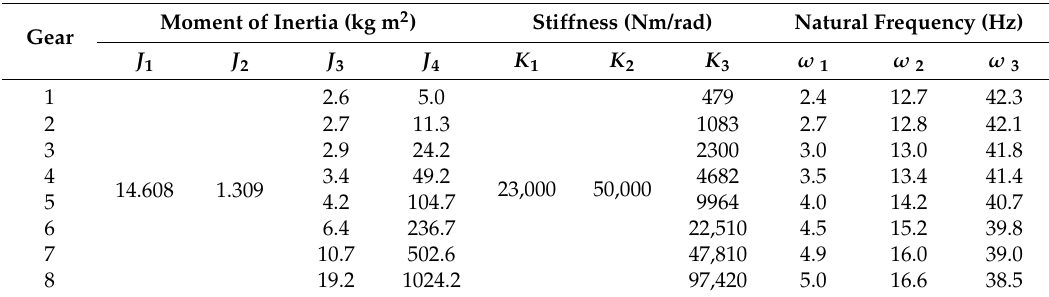
Table 1. The natural frequency analysis of the powertrain system.